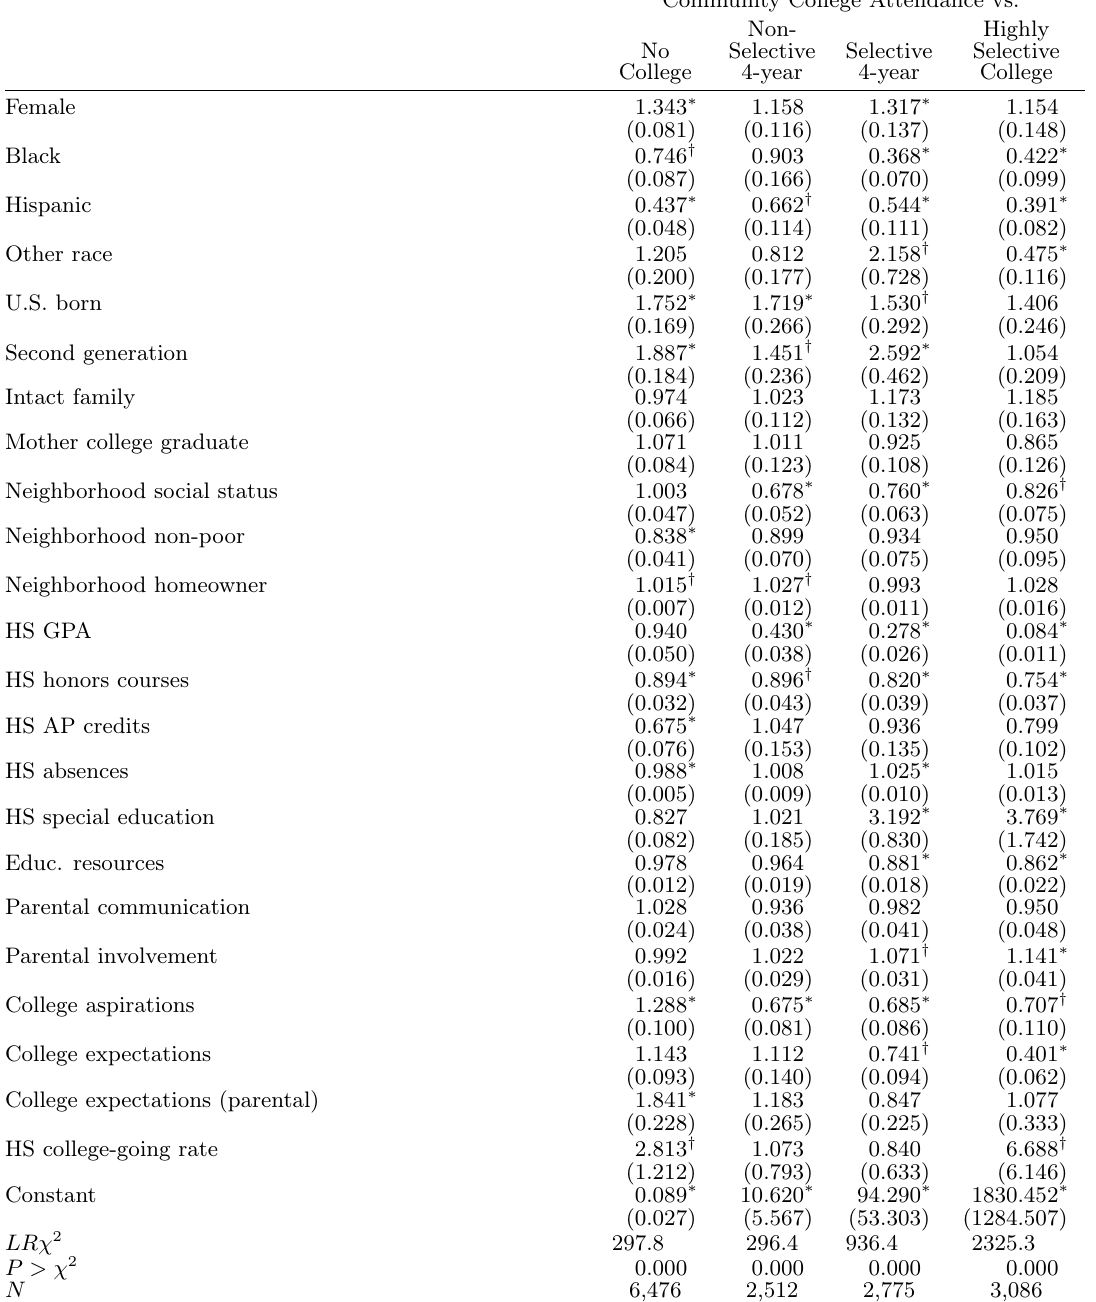
Table 2: Logistic Regression Estimates for Models Predicting Community College Attendance Community College Attendance